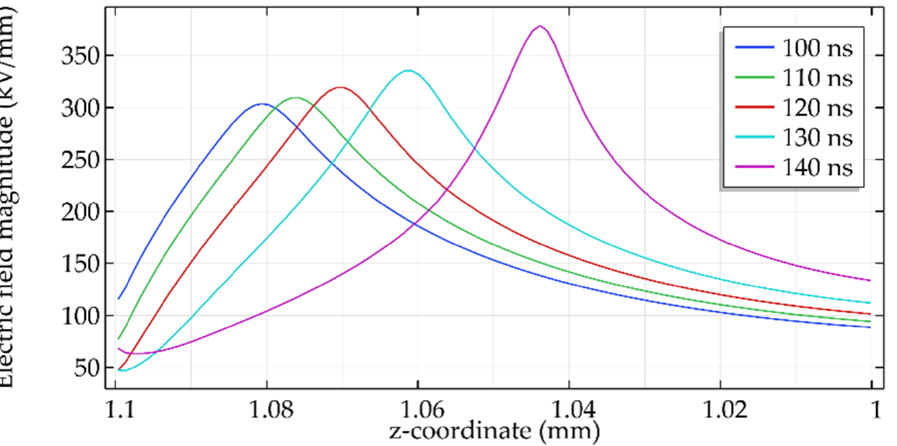
Figure 8. Electric field magnitude (kV/mm) along the line ( 𝑂 ) (Figure 1) at several instants in the 1st case.